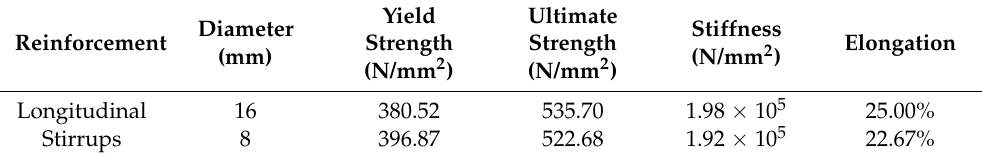
Table 3. Reinforcement parameters.